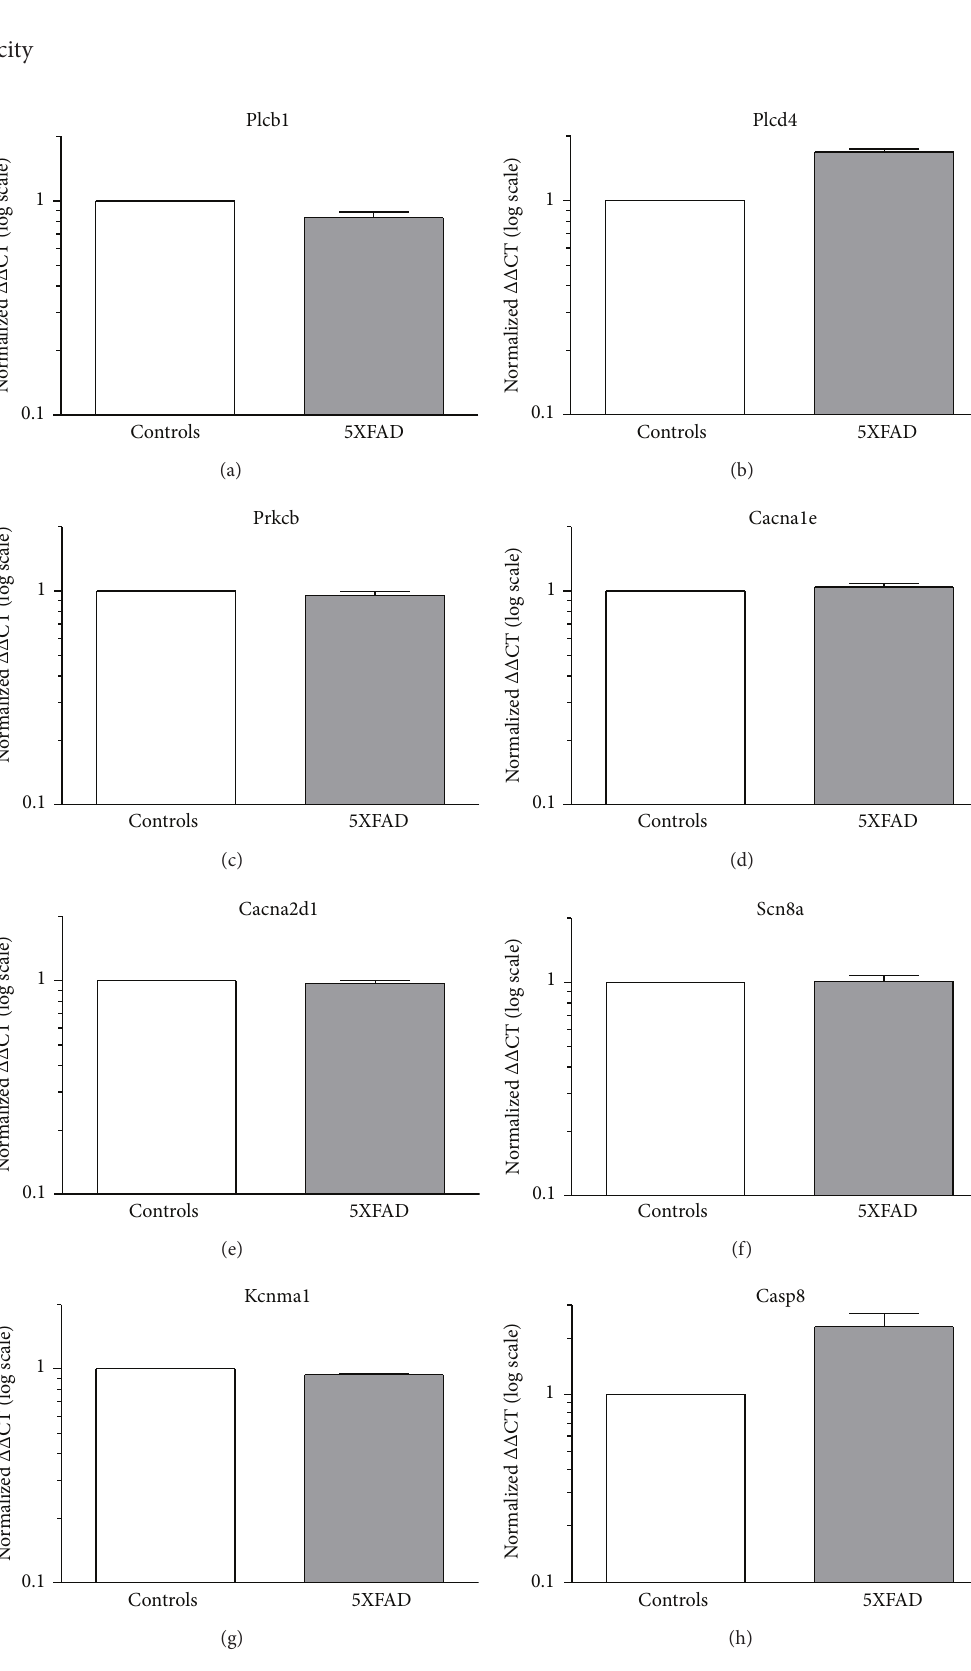
2.3 -loop, Prkcb, Plcb1, Scn8a, Plcd4, v II-III